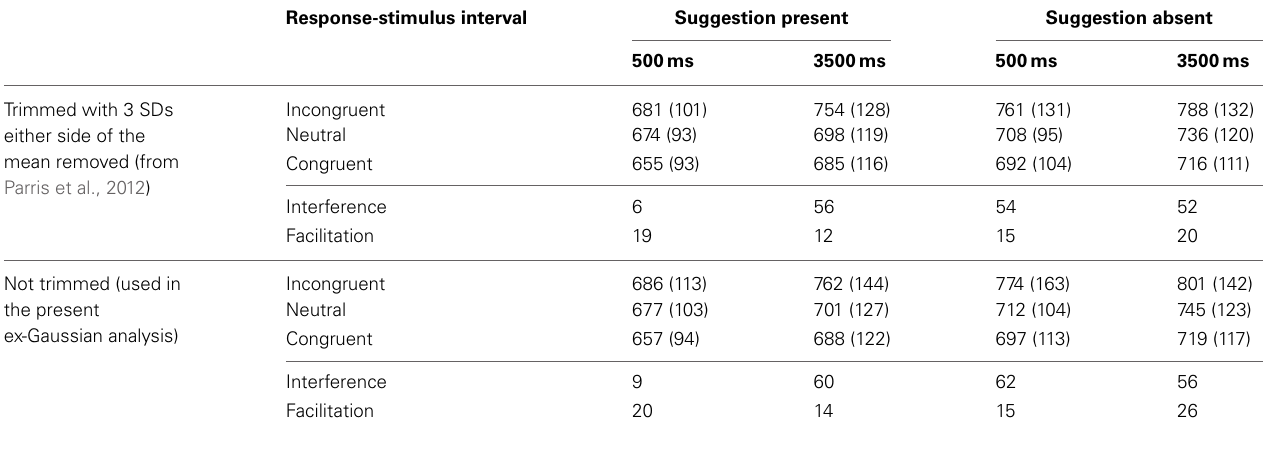
Table 2 | A comparison of trimmed and non-trimmed means in milliseconds (with standard deviations in brackets) from Parris et al. (2012) as a function of Stroop stimulus, Response-Stimulus Interval, and presence or absence of